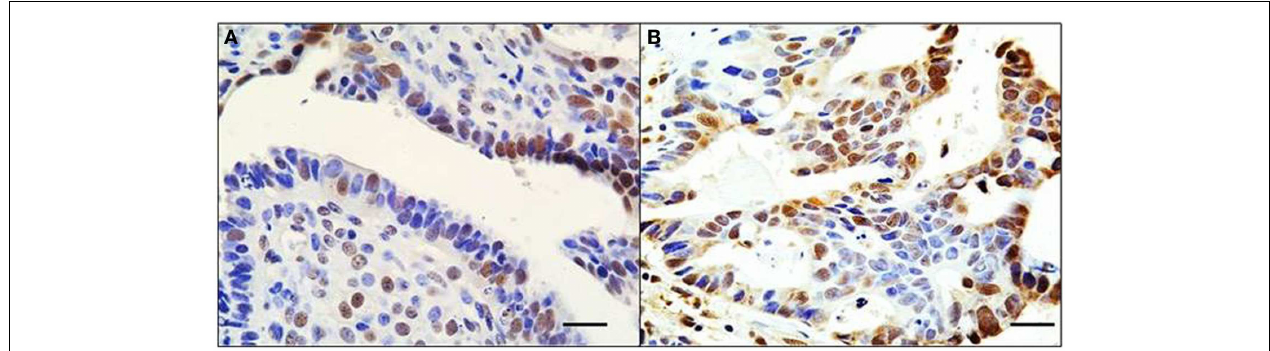
these tumors with respect to loss of expression of the SWI/SNF subunits, in this case, BRG1.These pictures illustrate the problems in deciding whether a tumor is actually negative for expression of a given subunit. Original magnification: 63x; scale bar = 20 µ